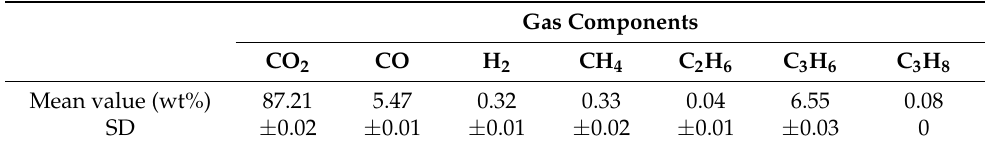
Table 2. The composition of the gas phase evolved through the liquefaction of blackcurrant pomace in this